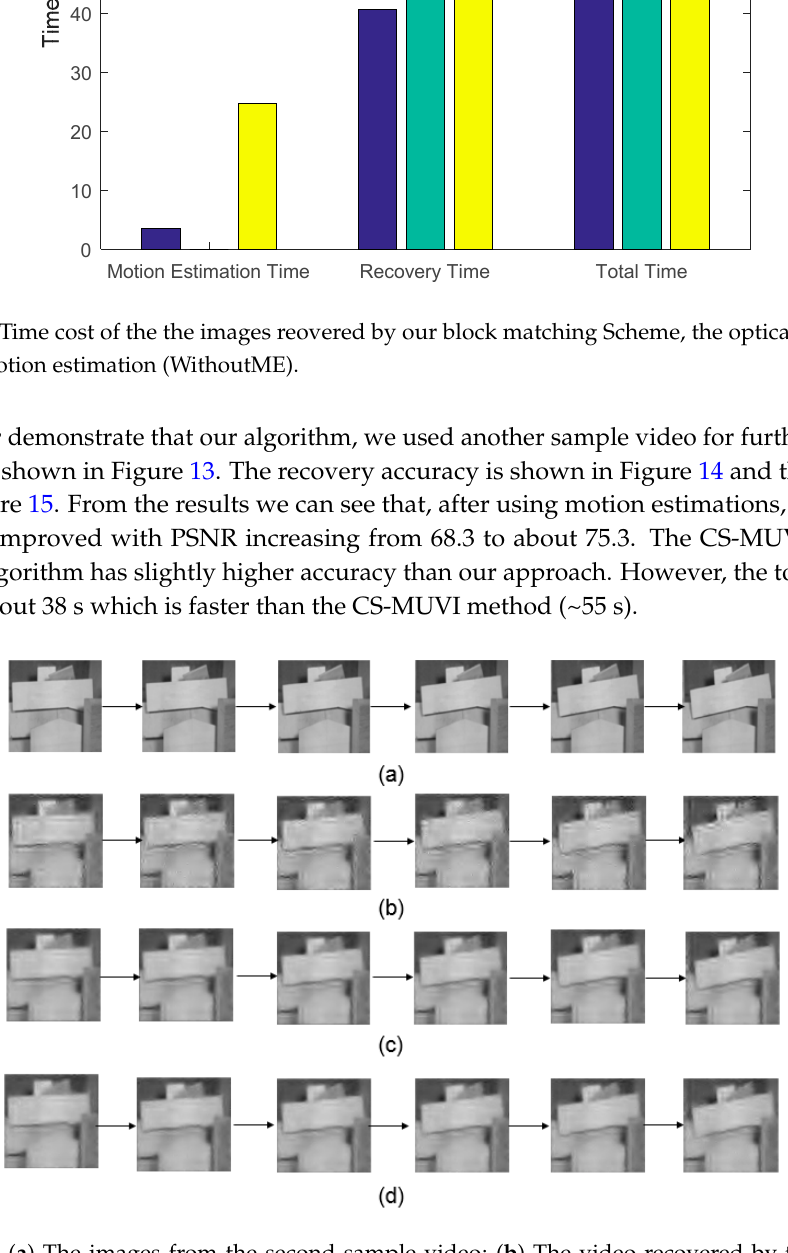
compressive sensing algorithm; ( c ) The video is recovered by CS-MUVI; ( d ) The video is recovered using our proposed block match motion estimation.